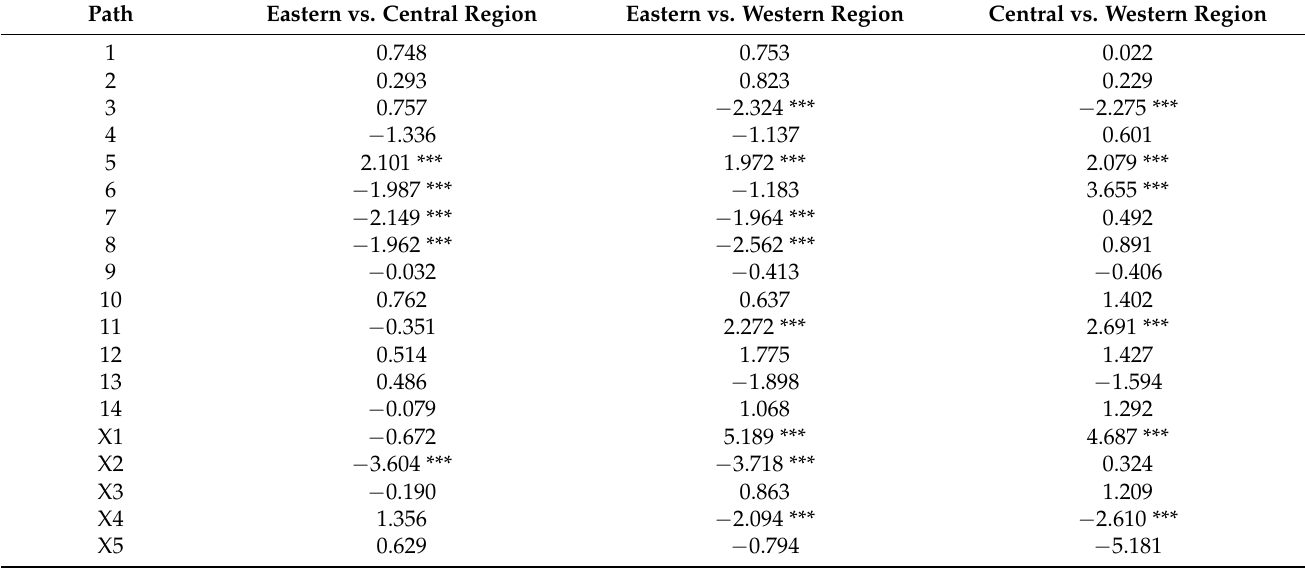
Table 7. The critical path coefficient ratios of regional differences.